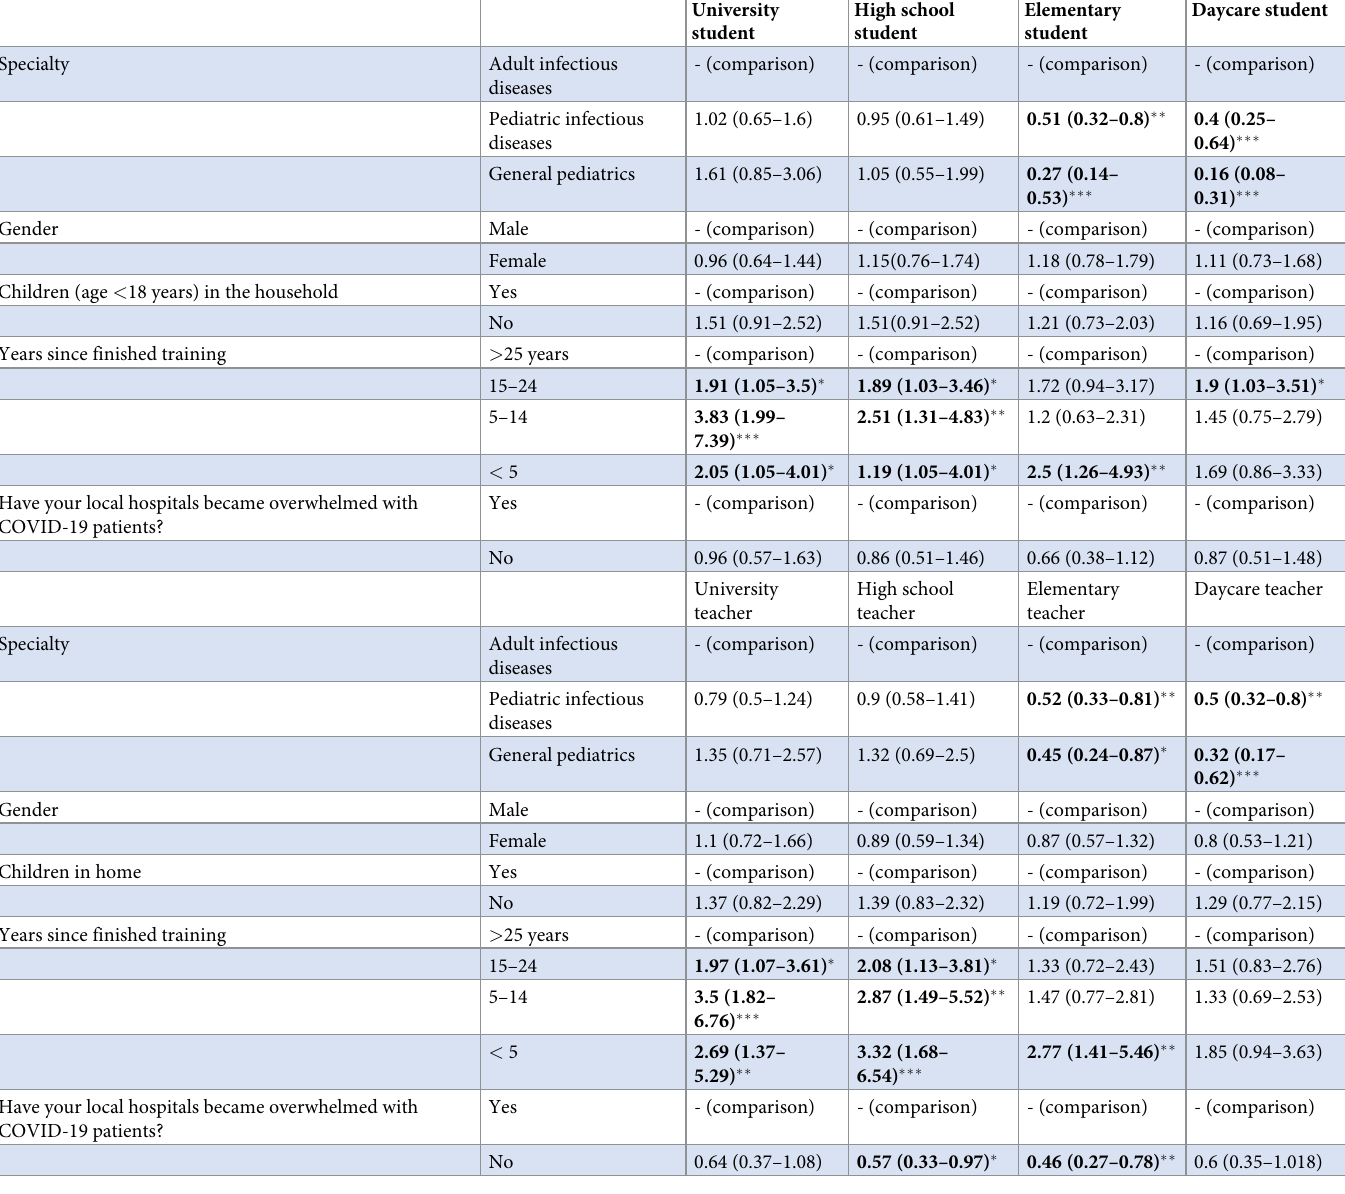
Table 4. Adjusted odds ratio (95% confidence interval) of ordinal regression for predictors influencing the risk assessment for students and teachers in each educa- tional